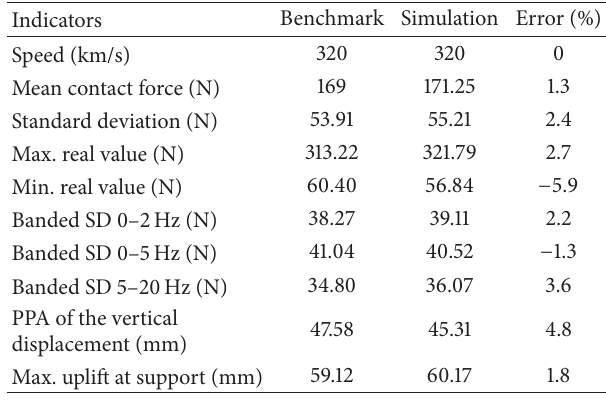
Table 1: Validation of the present model according to the bench- mark results.